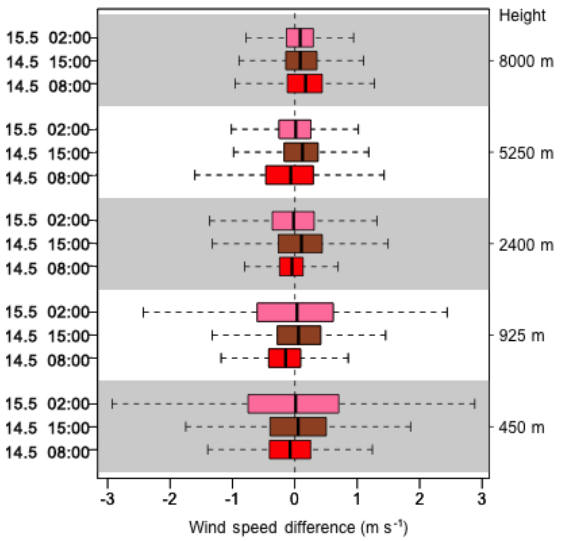
Figure 15. Wind speed differences between HR and HR_RESHIFT in domain